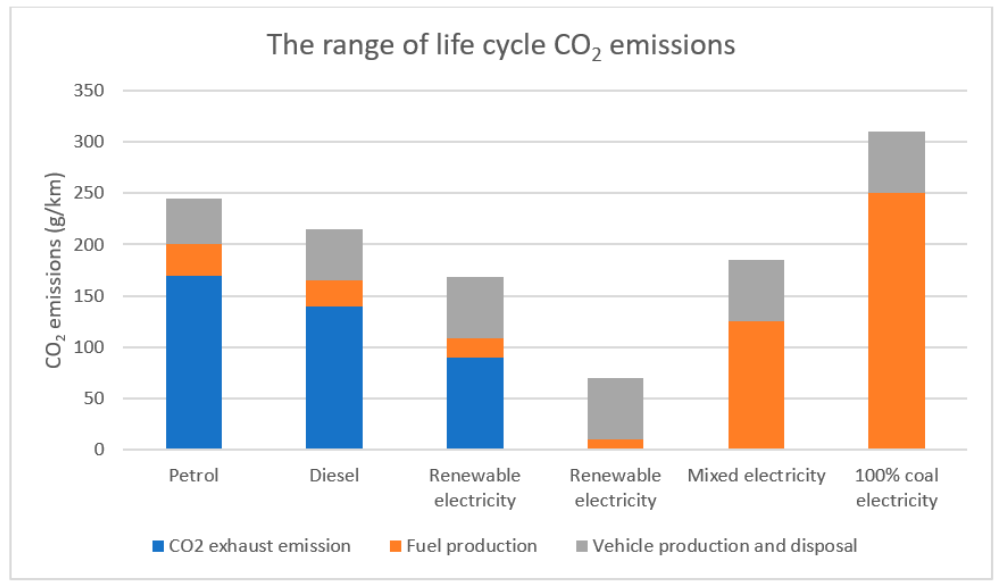
Figure 5. The range of life cycle CO 2 emissions of different types of fuels [15].